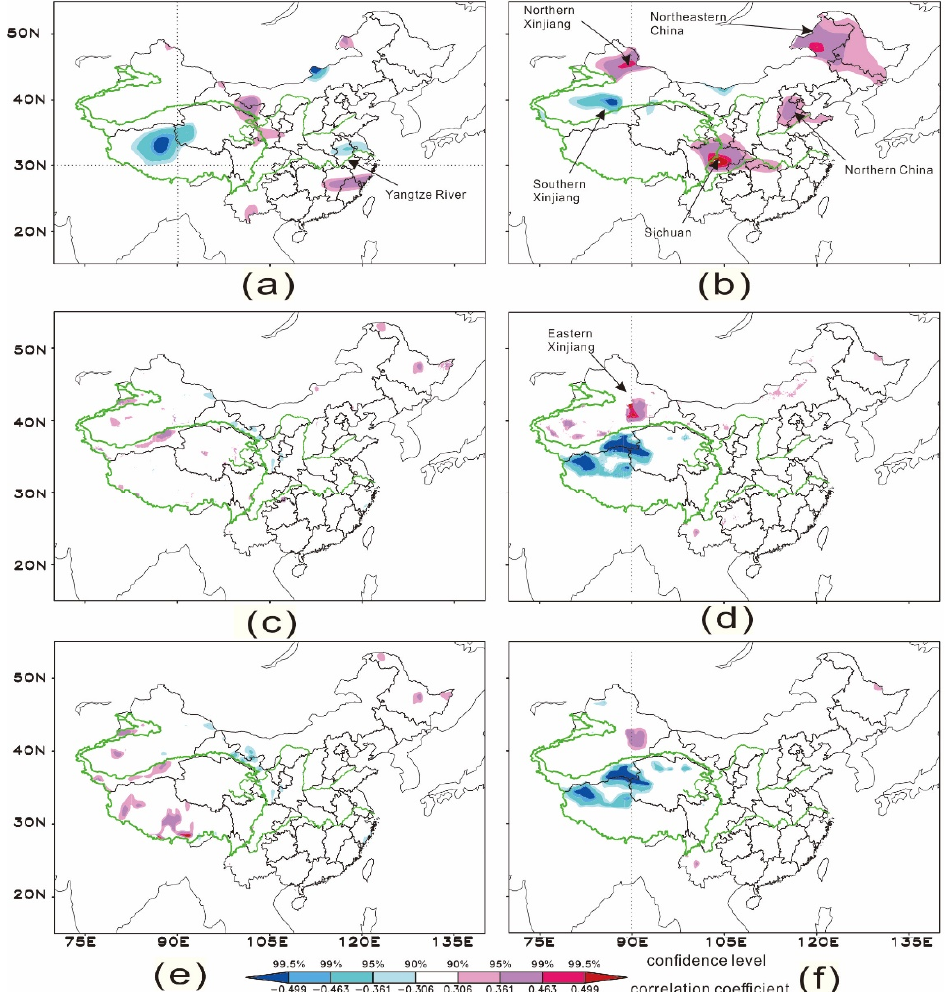
Figure 2. Correlation analysis between the surface meteorological variables and the vertical motion of air over the Indian Ocean. ( a ) Correlation between the precipitation and the vertical velocity in June. ( b ) Correlation between the precipitation and the vertical velocity in January. ( c ) Correlation between the surface pressure and the vertical velocity in June. ( d ) Correlation between the vertical velocity and the surface pressure in January. ( e ) Correlation between the vertical velocity and the surface temperature in June. ( f ) Correlation between the surface temperature and the vertical velocity in January.